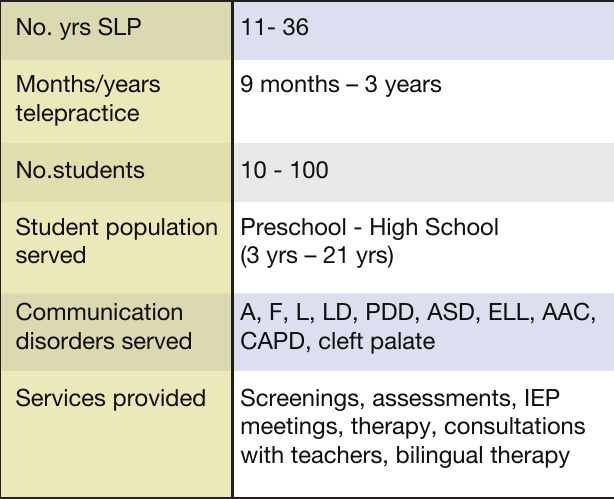
Table 1 Summary of Qualitative Interview Questions